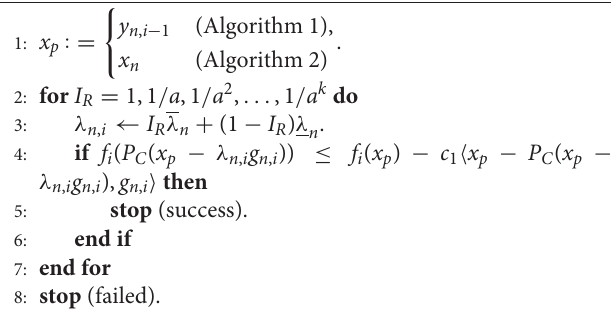
Algorithm 4: Logarithmic-interval armijo line